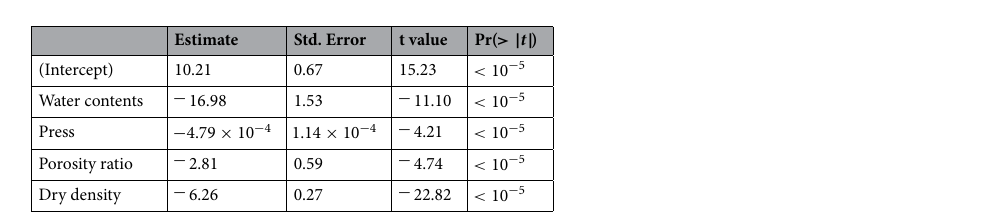
Table 2. Estimated covariate coefficients for multiple linear